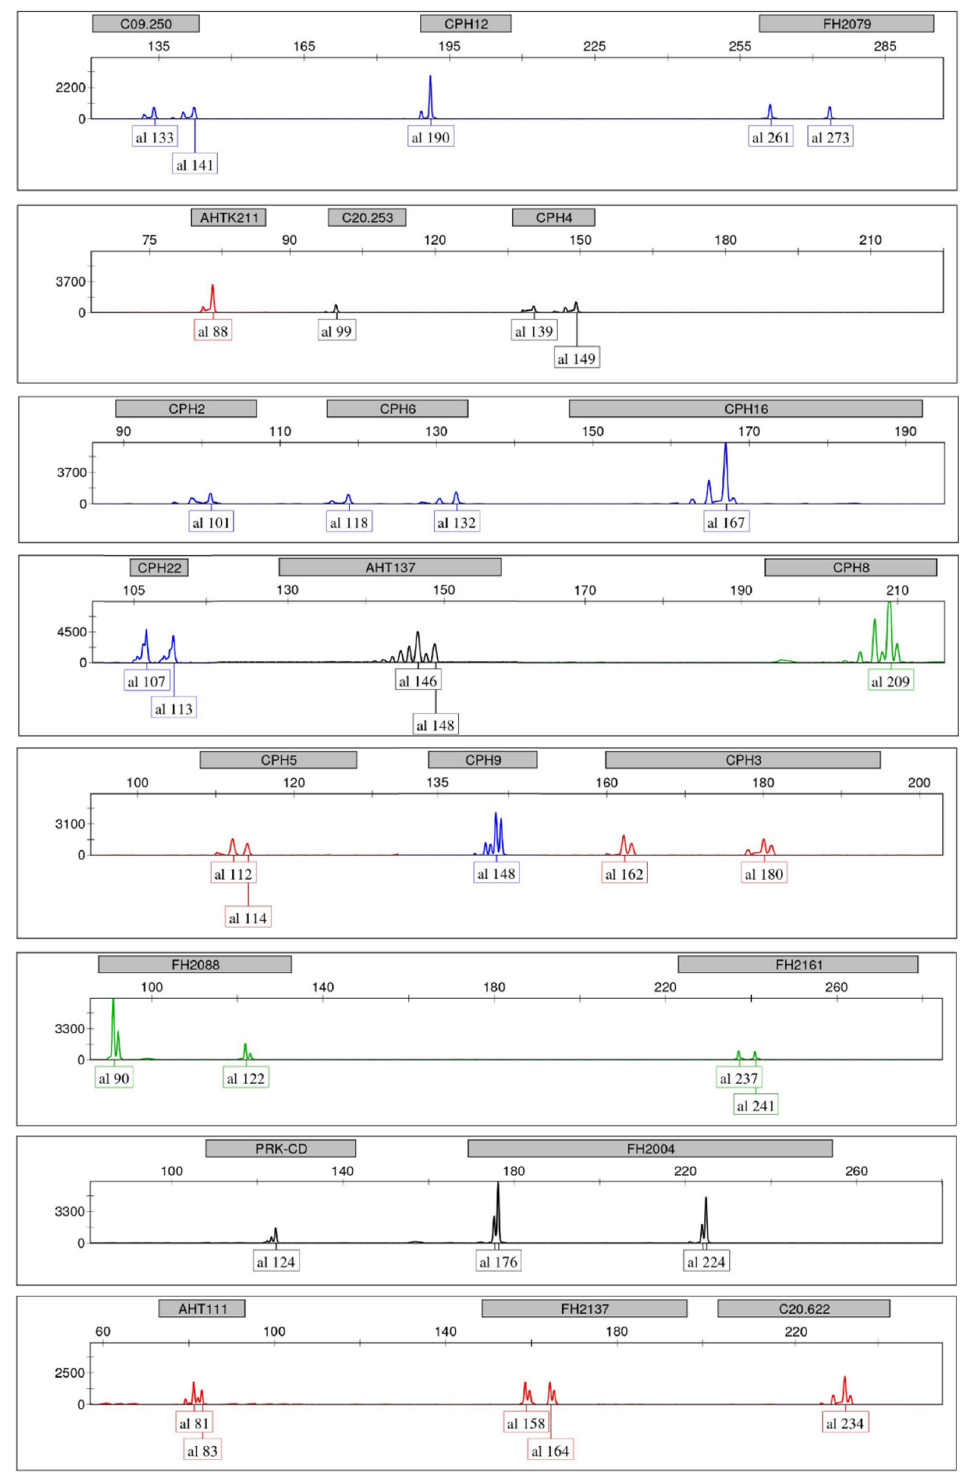
Figure 1. GeneMapper output showing complete genetic profile at 22 STR loci obtained using the ideal template amount of 5 ng from a wolf muscle sample in the amplification reactions of three multiplexes, and loading 2 µL of five-fold dilutions of the amplicons onto an ABI PRISM 3130 Genetic Analyzer. Allele calls in base pairs are indicated in boxes on the x-axis, while the y-axis shows relative fluorescent units (RFU) at different scales in the different panels. For graphic convenience, markers are not clustered according to their respective amplification multiplex.